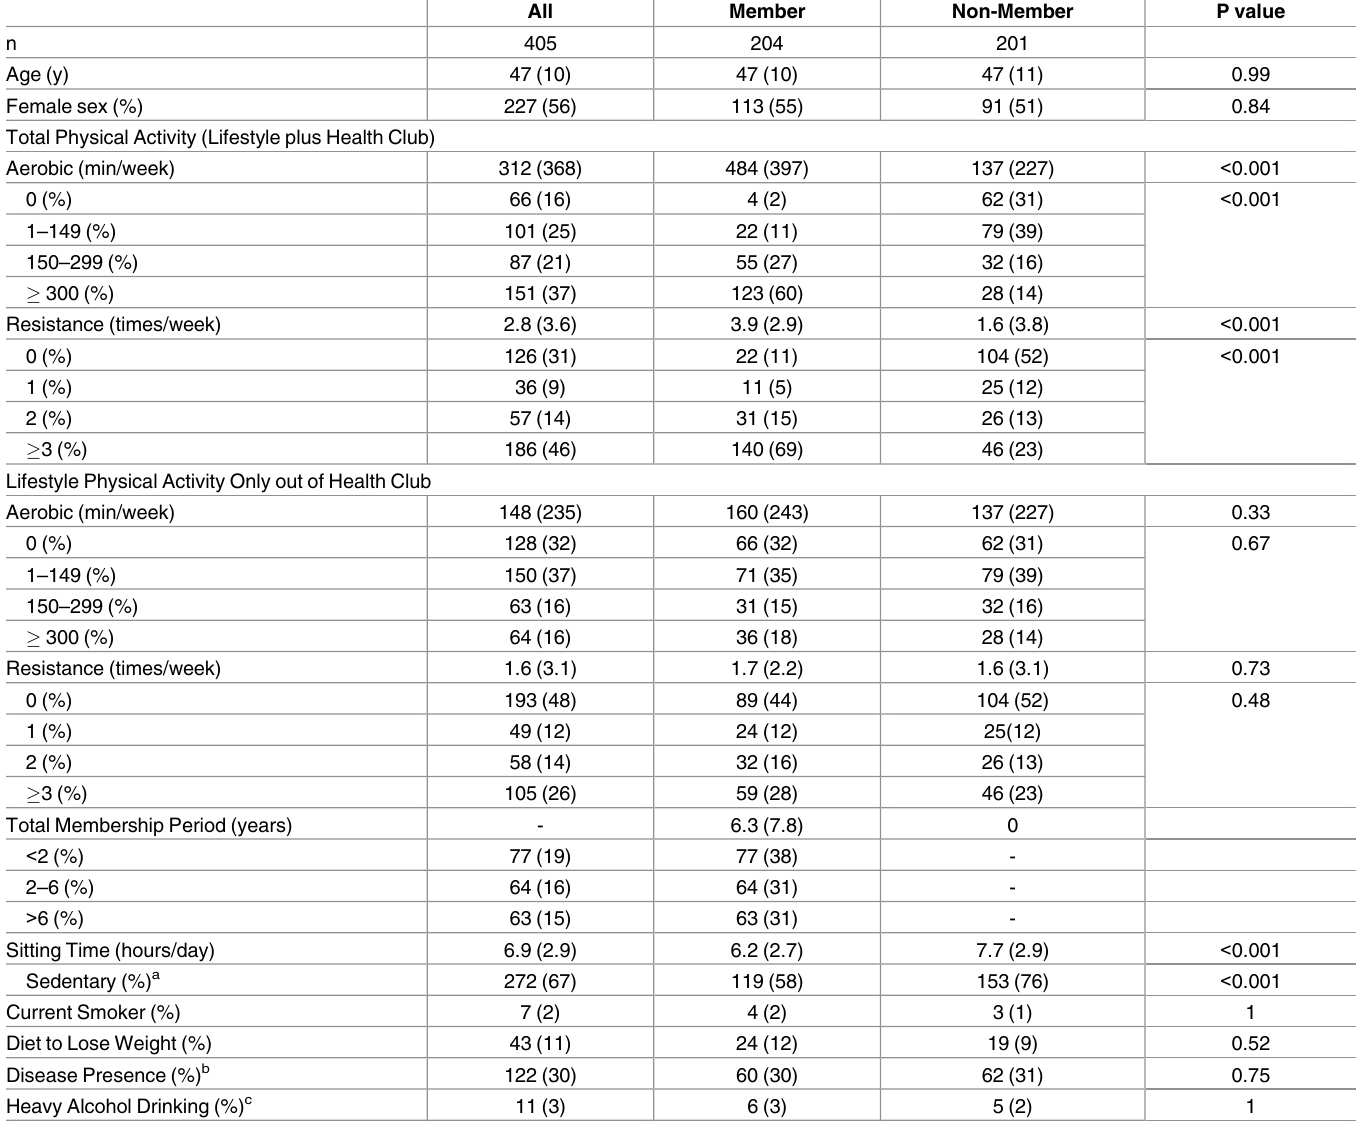
Table 1. Demographic characteristics and physical activity by health club membershipstatus. All